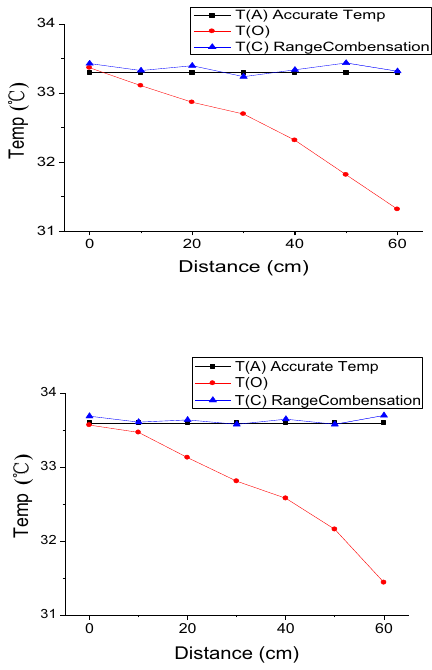
Figure 3. T (O), T (A) ,T(C) of four subjects As the fitting algorithm used the data from the 6 points from 0 to 60cm, in order to ensure the reliability of the system in the full range of 0 to 60cm, randomly selected subject A to measure temperature at random distances from 0 to 60cm, and the recorded results were shown in Figure 4. Figure 4. T(C), T (A) of subject A In order to further explore the effect of skin color had on the accuracy of the system temperature measurement, two subjects were randomly coated with black and white edible pigments on the forehead to simulate the black and white complexion. The results of the two sets of tests measured by the infrared temperature measurement system with distance compensation in the range of 0- 60cm were compared with the actual temperature values measured by Microlife FR1DM1, and the maximum error was no more than 0.2 (cid:263) . Figure 5 was the result of black skin and white skin. It could be seen that the skin color had no effect on the system measurement accuracy.